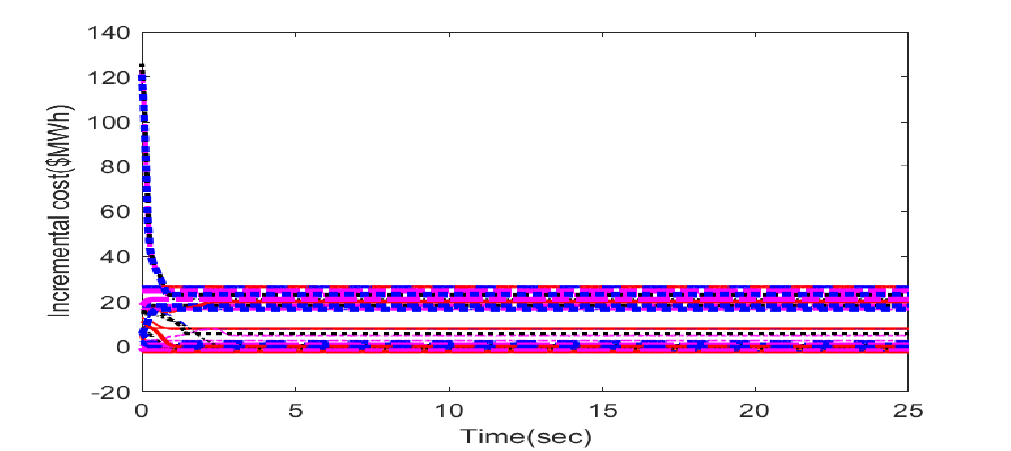
Figure 11. Modified IC consensus for forty-unit